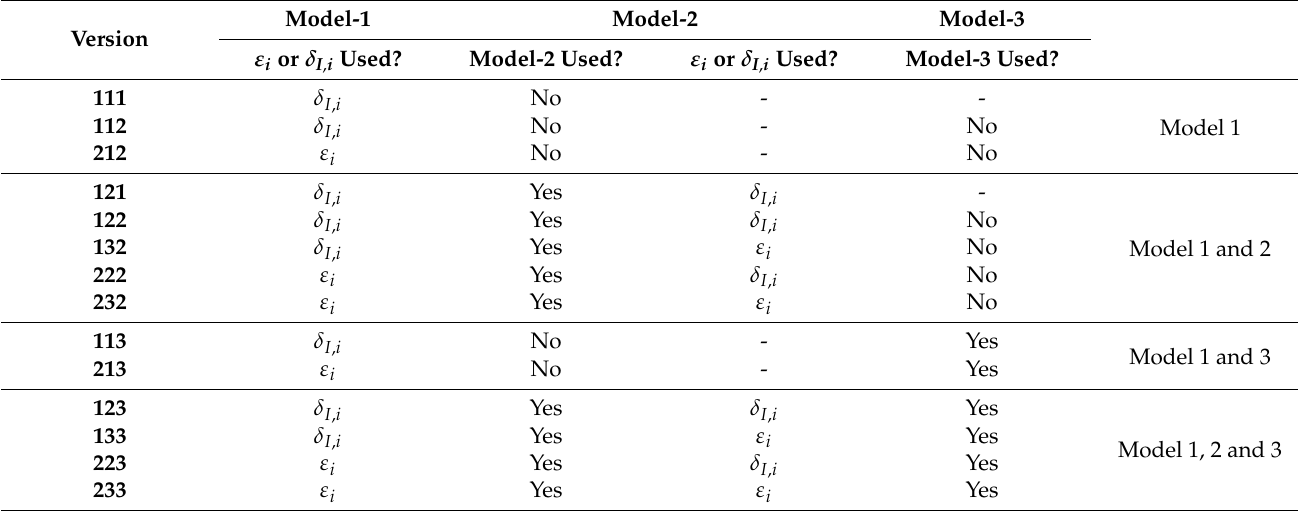
Table 2. Different odometry versions and the models they used.